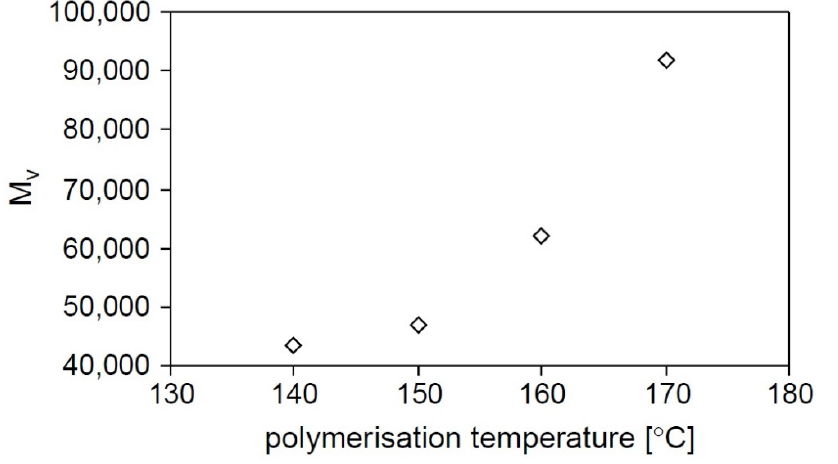
Figure 3. Viscosity average molar mass for various polymerization temperatures. Reprinted from Reference [10], under open-access license.